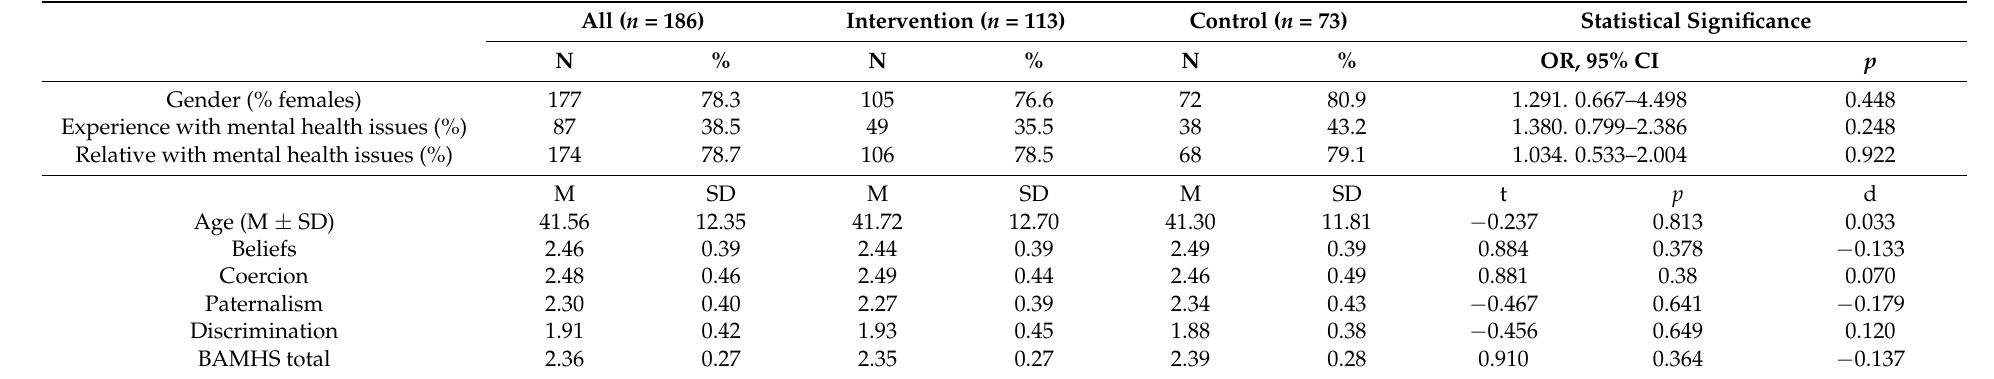
Table 3. Sociodemographic characteristics and baseline scores of mental health participants.